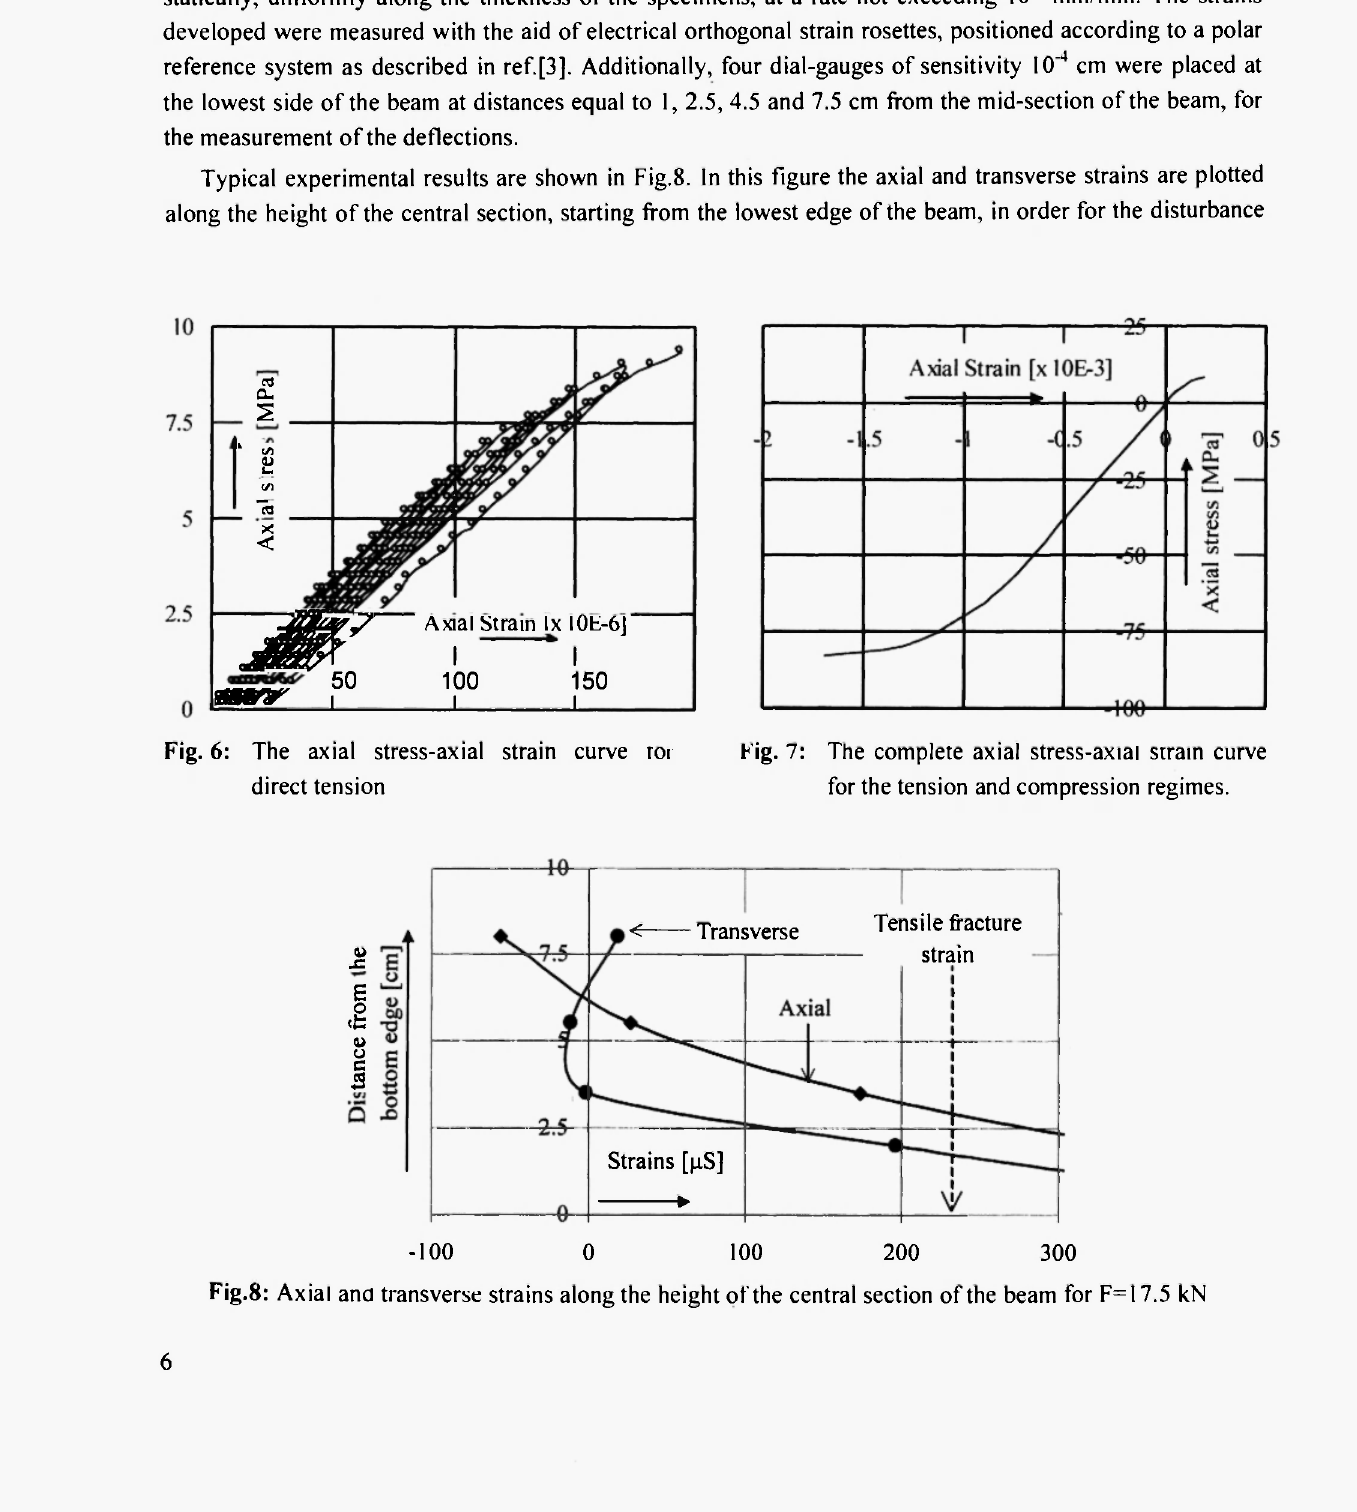
Strains [μ5] • -100 0 100 200 300 Fig.8: Axial and transverse strains along the height of the central section of the beam for F=I7.5 kN